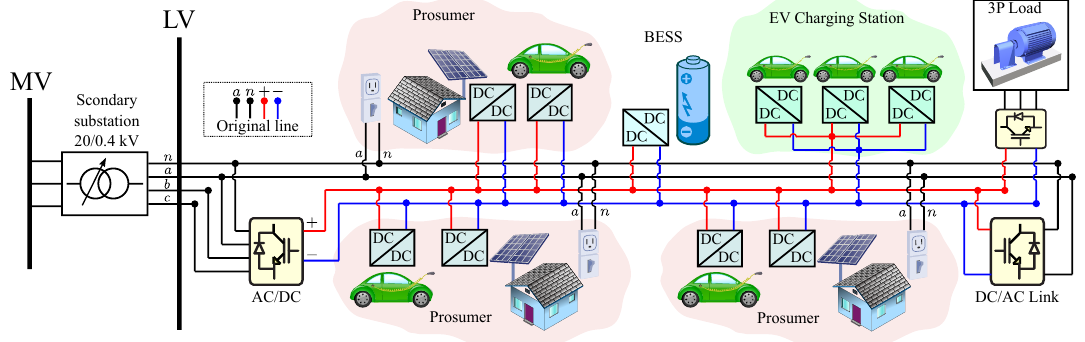
Figure 7. Hybrid AC/DC LV distribution network by replacing two AC conductors by DC